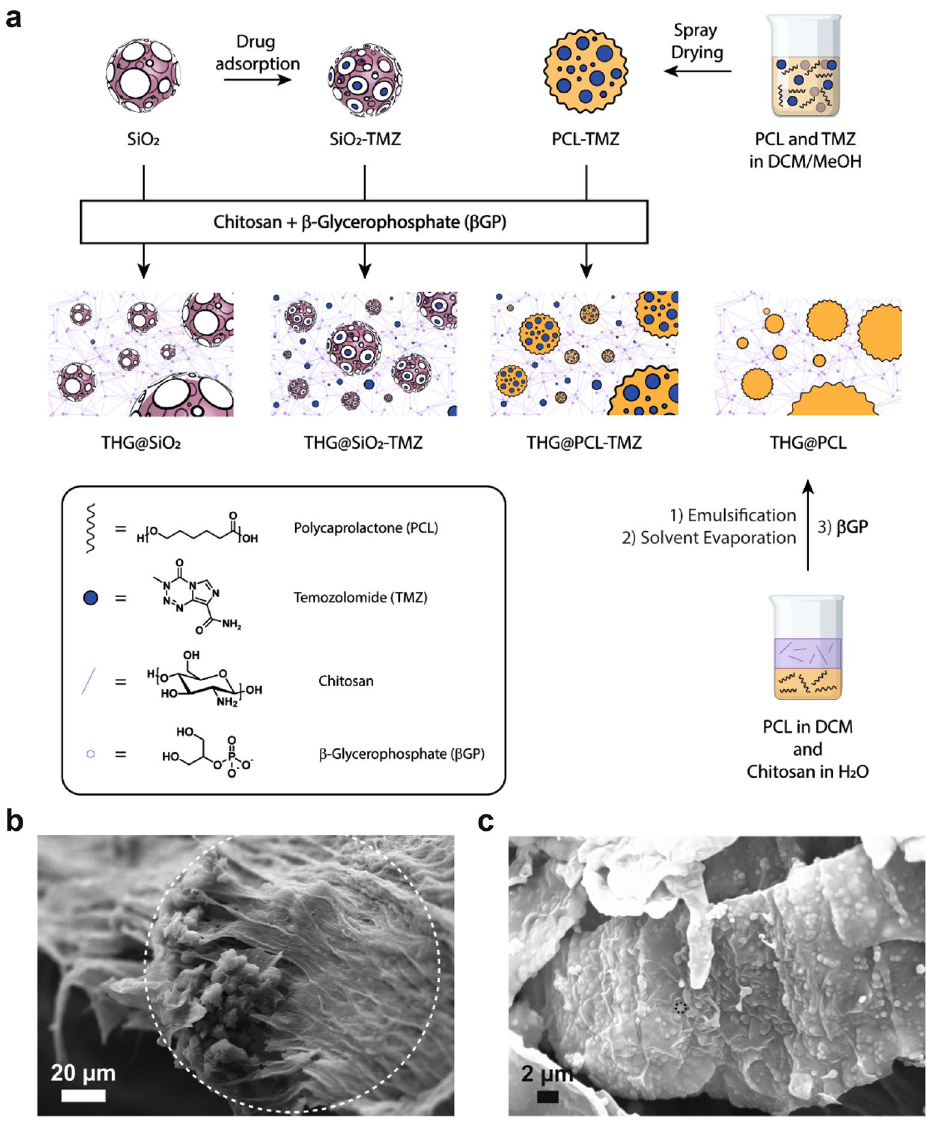
Figure 1. Explored strategies for loading TMZ in chitosan-based thermogels. ( a ) For SiO 2 -TMZ, the drug is adsorbed on mesoporous silica (SiO 2 ) via electrostatic interactions, and the colloid is then dispersed in the thermogel matrix. For PCL-TMZ, the drug is dissolved together with PCL in a dichloromethane/methanol (DCM/MeOH) mixture and spray-dried to afford PCL-TMZ microparticles that physically entrapped the drug. The drug-loaded microparticles were then formulated in the chitosan/βGP thermogel (THG). ( b ) Scanning electron micrographs of freeze-dried THG@PCL-TMZ. ( c ) THG@PCL-SiO 2 -TMZ. TMZ-loaded microcarriers are highlighted with dashed circles.